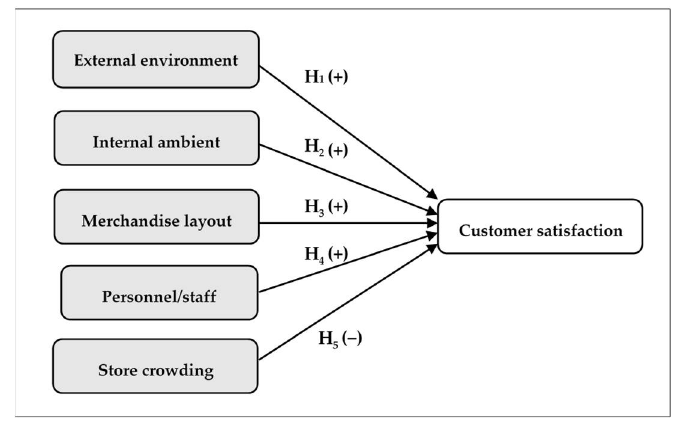
Figure 1. Proposed research hypotheses.